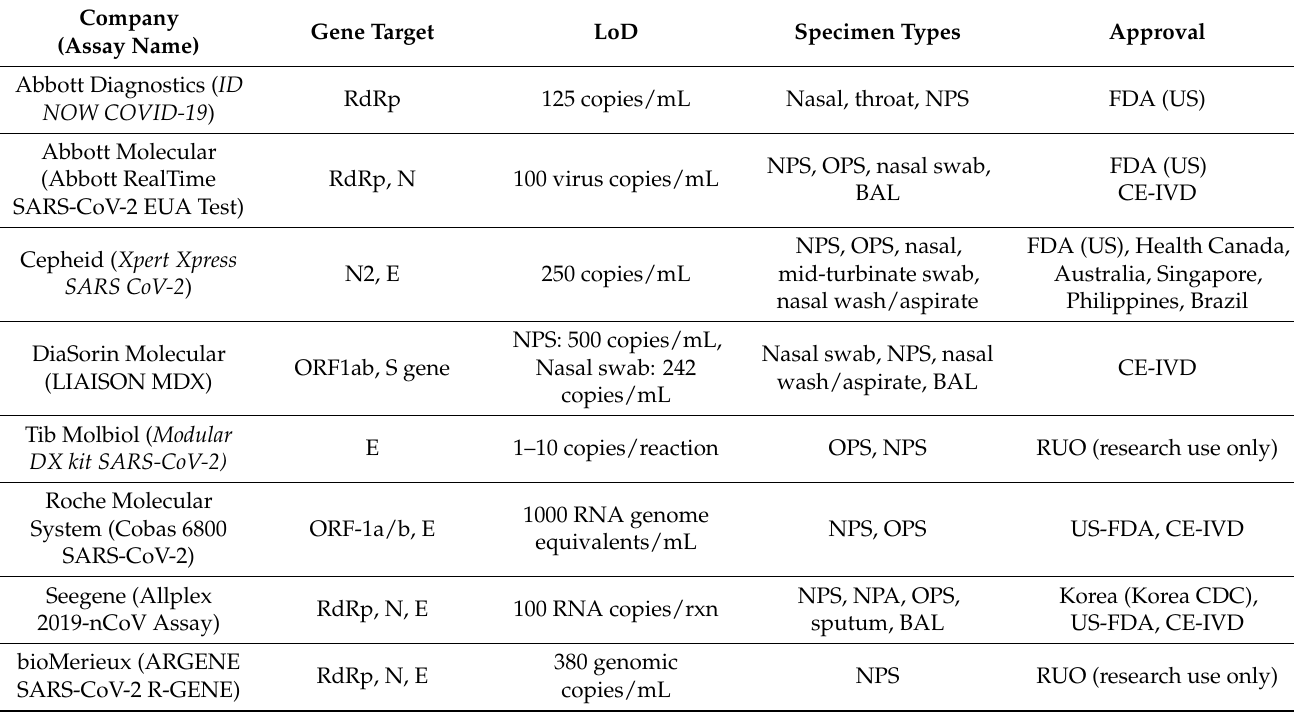
Table 2. Commercially available diagnostics kits mainly used in Italy in real-time reverse transcription polymerase chain reaction (rRT-PCR) with gene target and limit of